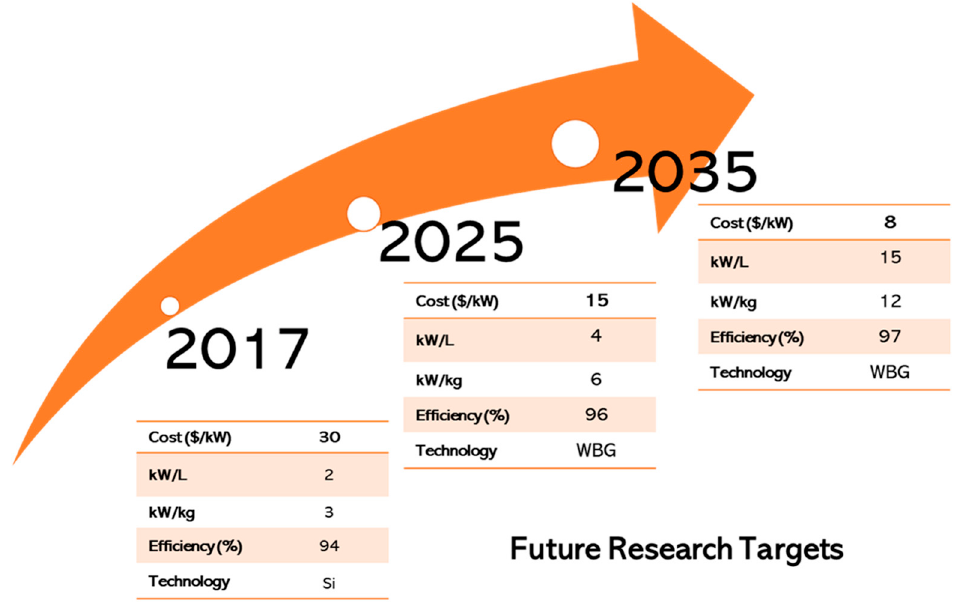
Figure 36. Estimated power density trend of integrated on-board charger (iOBC) with DC/DC con-